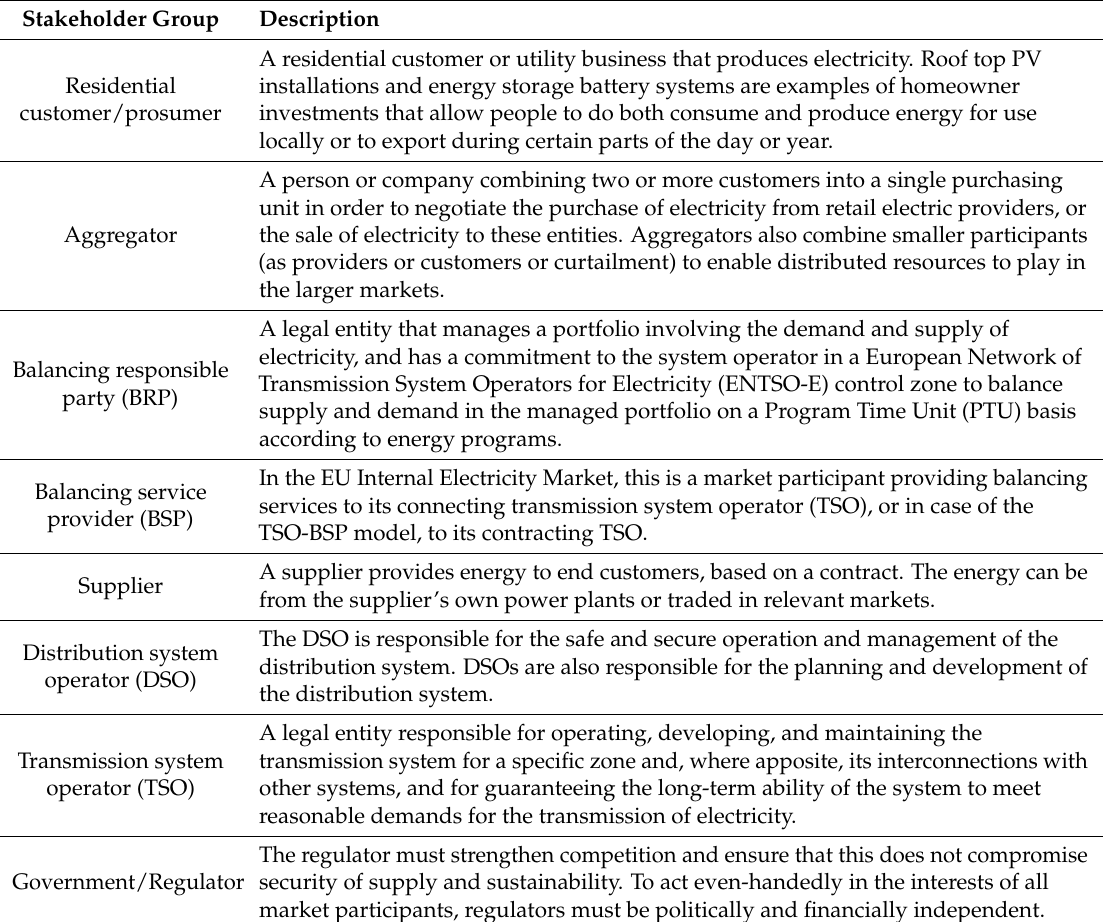
Table 1. Stakeholders in smart grids environments and descriptions of their roles (adapted from